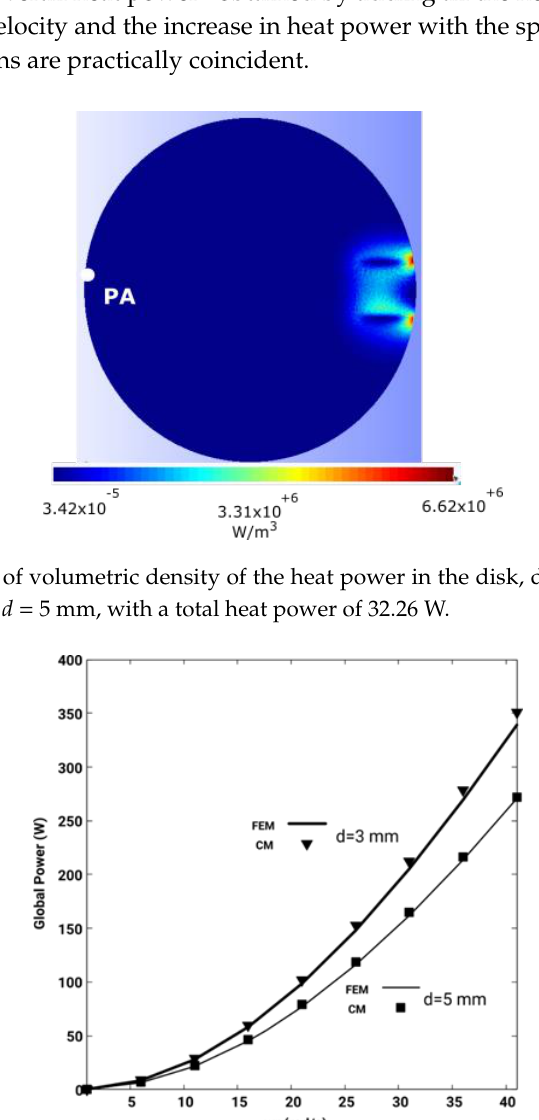
Figure 9. Comparison of the global heat power in the disk as a function of w r , for d = 3 and 5 mm, using the CM and the FEM. Both simulations are practically coincident. 4.2.2. Analysis of the thermal transient regime